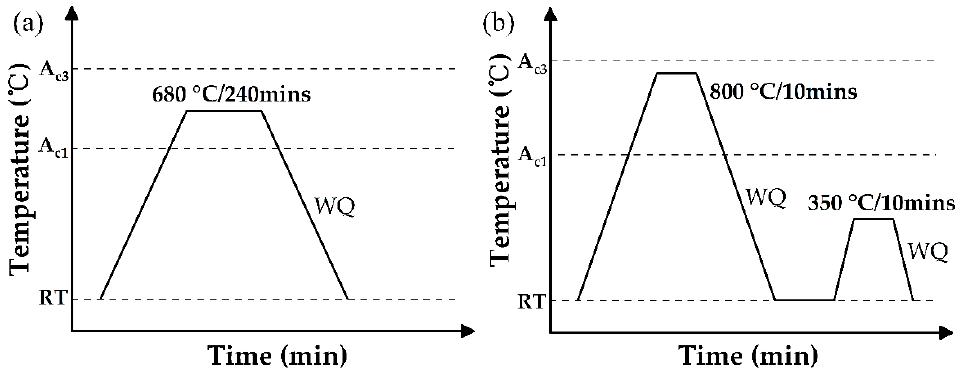
Figure 1. Schematic illustration of thermal processing routes employed in the present work, includ- ing the ( a ) IA and ( b ) IA-Q&P processes. WQ: water quenching; RT: room temperature. the ( a ) IA and ( b ) IA-Q&P processes. WQ: water quenching; RT: room